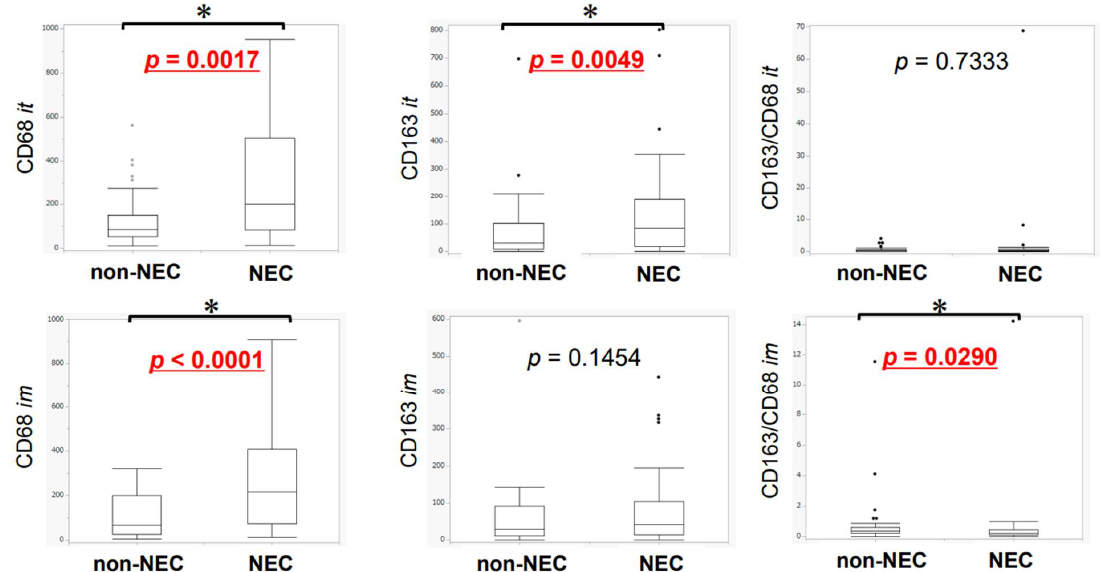
Figure 5. The difference in the abundance of macrophages expressing different markers between the NEC and non-NEC components in the same case (Wilcoxon signed-rank test). CD68- and CD163-positive macrophages infiltrating the NEC components were more abundant than those infiltrating the non-NEC components, the former in both intra-tumoral areas and invasive margins (it: p = 0.0017, im: p < 0.0001), and the latter only in intra-tumoral areas (it: p = 0.0049, im: p = 0.1454). CD163/CD68 ratio of infiltrating macrophages was higher in the non-NEC than in the NEC components in the areas of invasive margin (it: p = 0.7333, im: p = 0.0290). The points are outliers. * it: intra-tumoral, im: invasive margin.